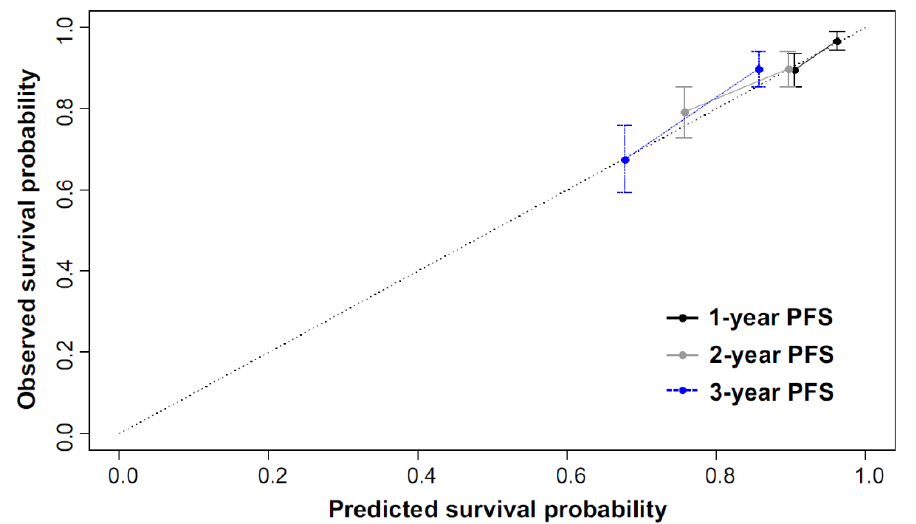
Figure 3. Calibration curve of radiomics nomogram in the validation set. Calibration curves for the radiomics nomograms of progression-free survival in the validation set for agreement between the estimated and the observed 1, 2 and 3 year PFS. Nomogram-estimated PFS is plotted on the x -axis; the observed PFS is plotted on the y -axis. The validation set was divided into two groups according to the survival duration; nomogram-estimated PFS and observed PFS based on the 1, 2, and 3 year PFS were calculated in each group. The diagonal dotted line represents the optimal estimation of PFS by an ideal model, in which the estimated outcome perfectly corresponds to the actual outcome. The solid lines with black, gray, and blue colors represent the performance of the nomogram. A close alignment with the diagonal dotted line indicates better estimation.